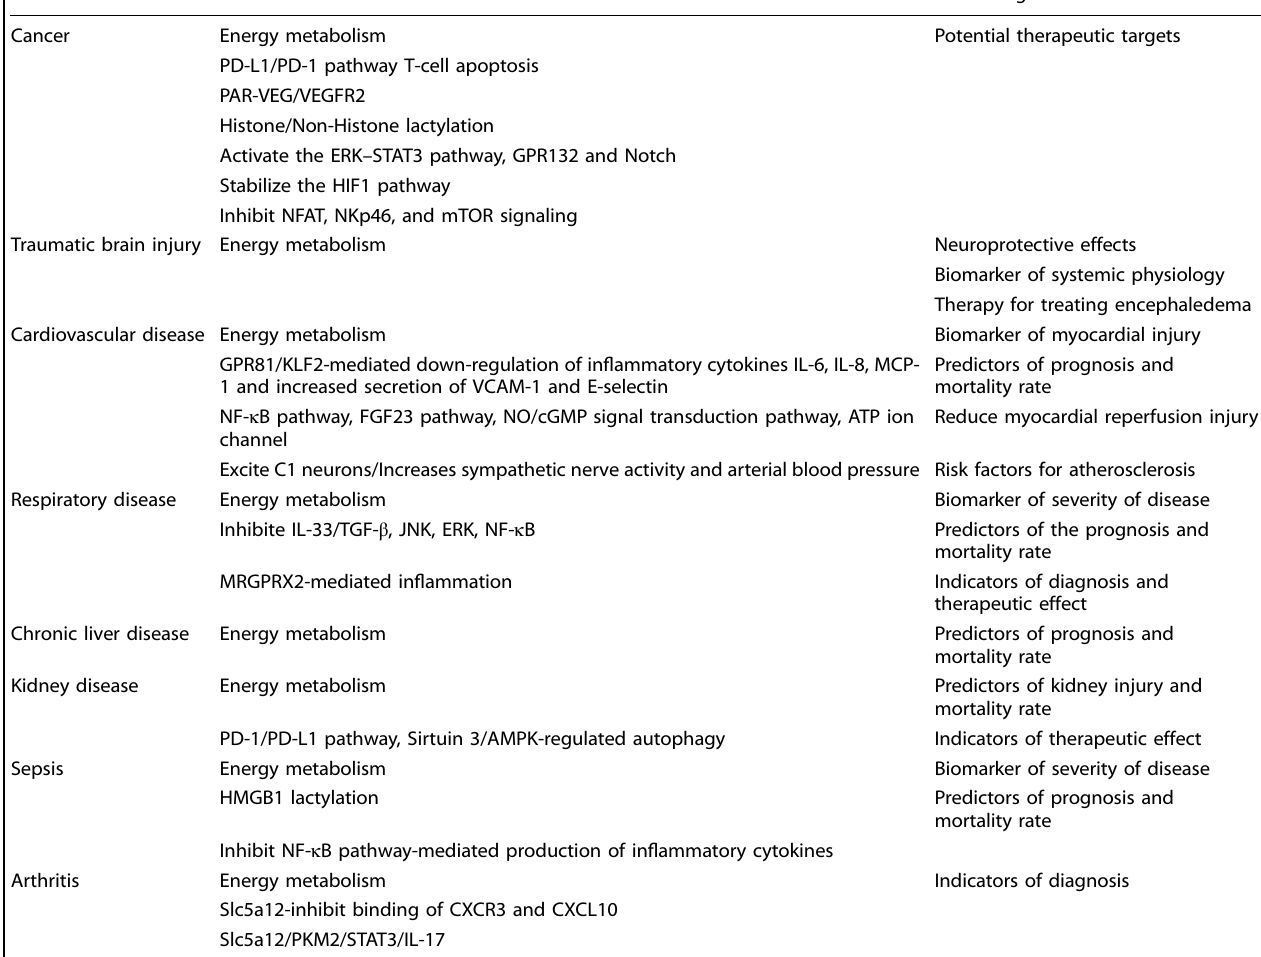
Table 2. Summary of lactate in disease and the related signaling pathways